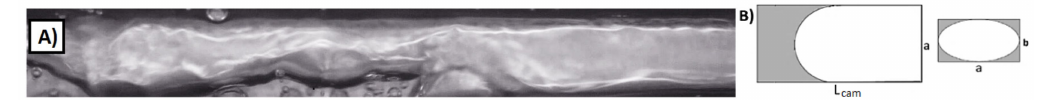
Figure 7. ( A ) Actual and ( B ) approximated shapes of vapor bubbles in longitudinal and transverse sections of the channel with flow direction, case III. Water, T in = 72 ◦ C, T out = 120 ◦ C, p in = 1.147 bar, ∆ p = 0.0016 bar, q = 270.5 kW / m 2 , G = 5.9 kg / (m 2 s), Re = 43.5, L